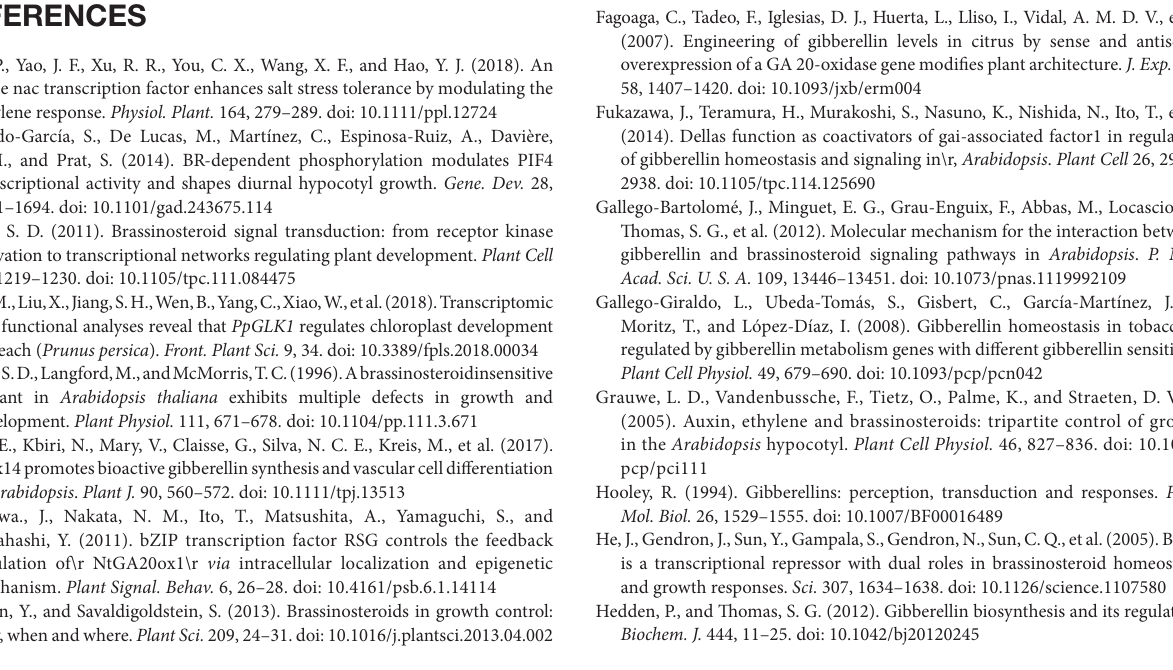
( Figure 6 ). Future study should focus on how GA stimulates the innate anti-oxidation defense responses against salt